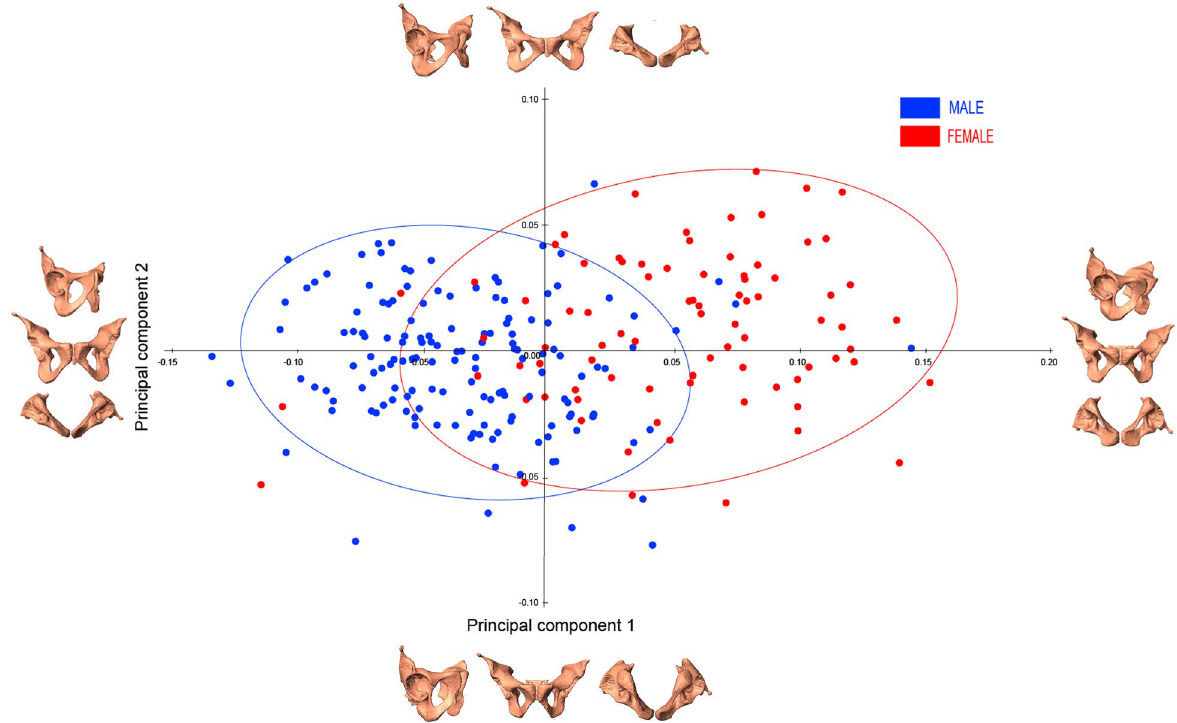
Fig. 3 The principal component plots for PC1 and PC2 with the 90% confidence ellipses for sex